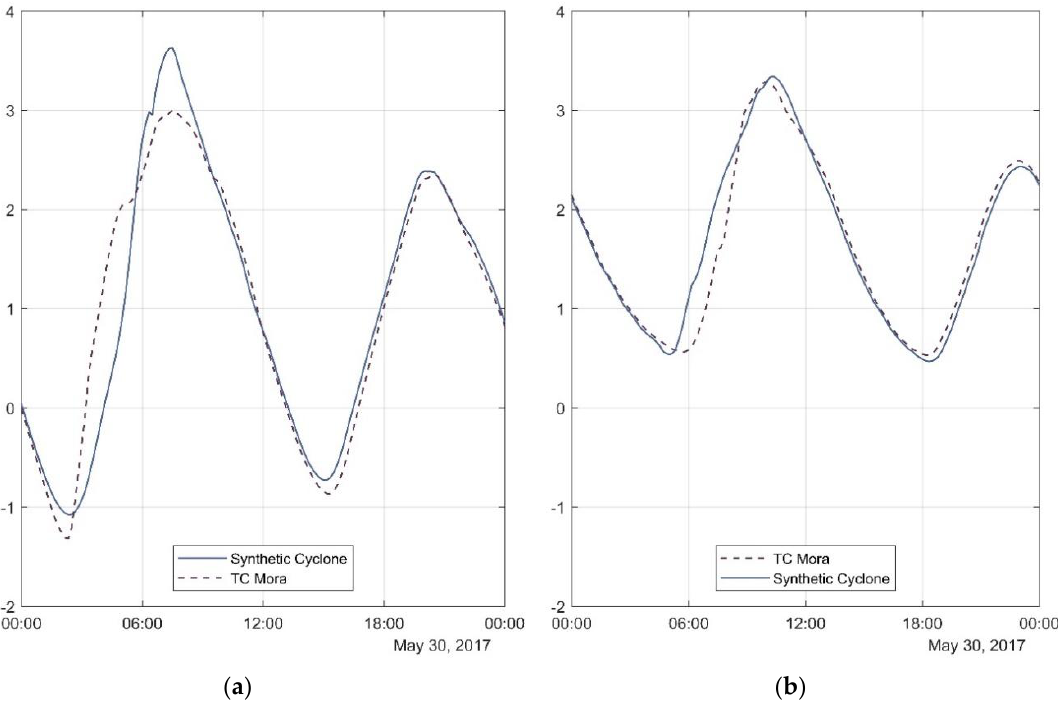
Figure 7. Water level of TC Mora and the synthetic cyclone in two locations. ( a ) Water level at Cox’s Bazar, and ( b ) Water level at Chittagong.